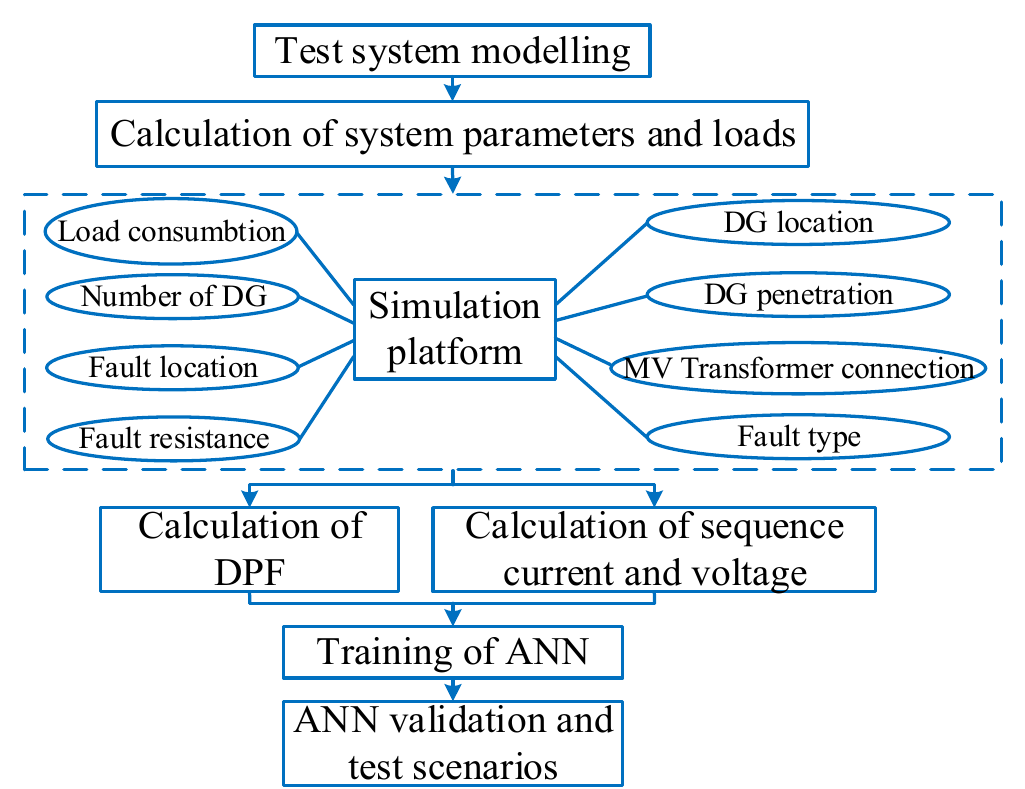
Figure 3. Flowchart of the ANN training procedure.